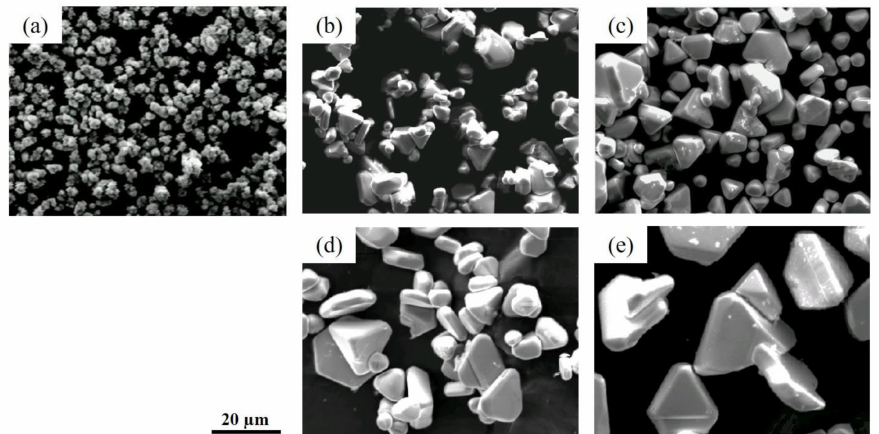
Figure 2. SEM images of starting material (ZnS) and solid run products. ( a ) Starting material (ZnS), ( b ) sphalerite synthesized at 500 ◦ C and 100 MPa (run no. 501), ( c ) sphalerite synthesized at 600 ◦ C and 100 MPa (run no. 601), ( d ) sphalerite synthesized at 700 ◦ C and 100 MPa (run no. 701), and ( e ) sphalerite synthesized at 800 ◦ C and 100 MPa (run no. 801).